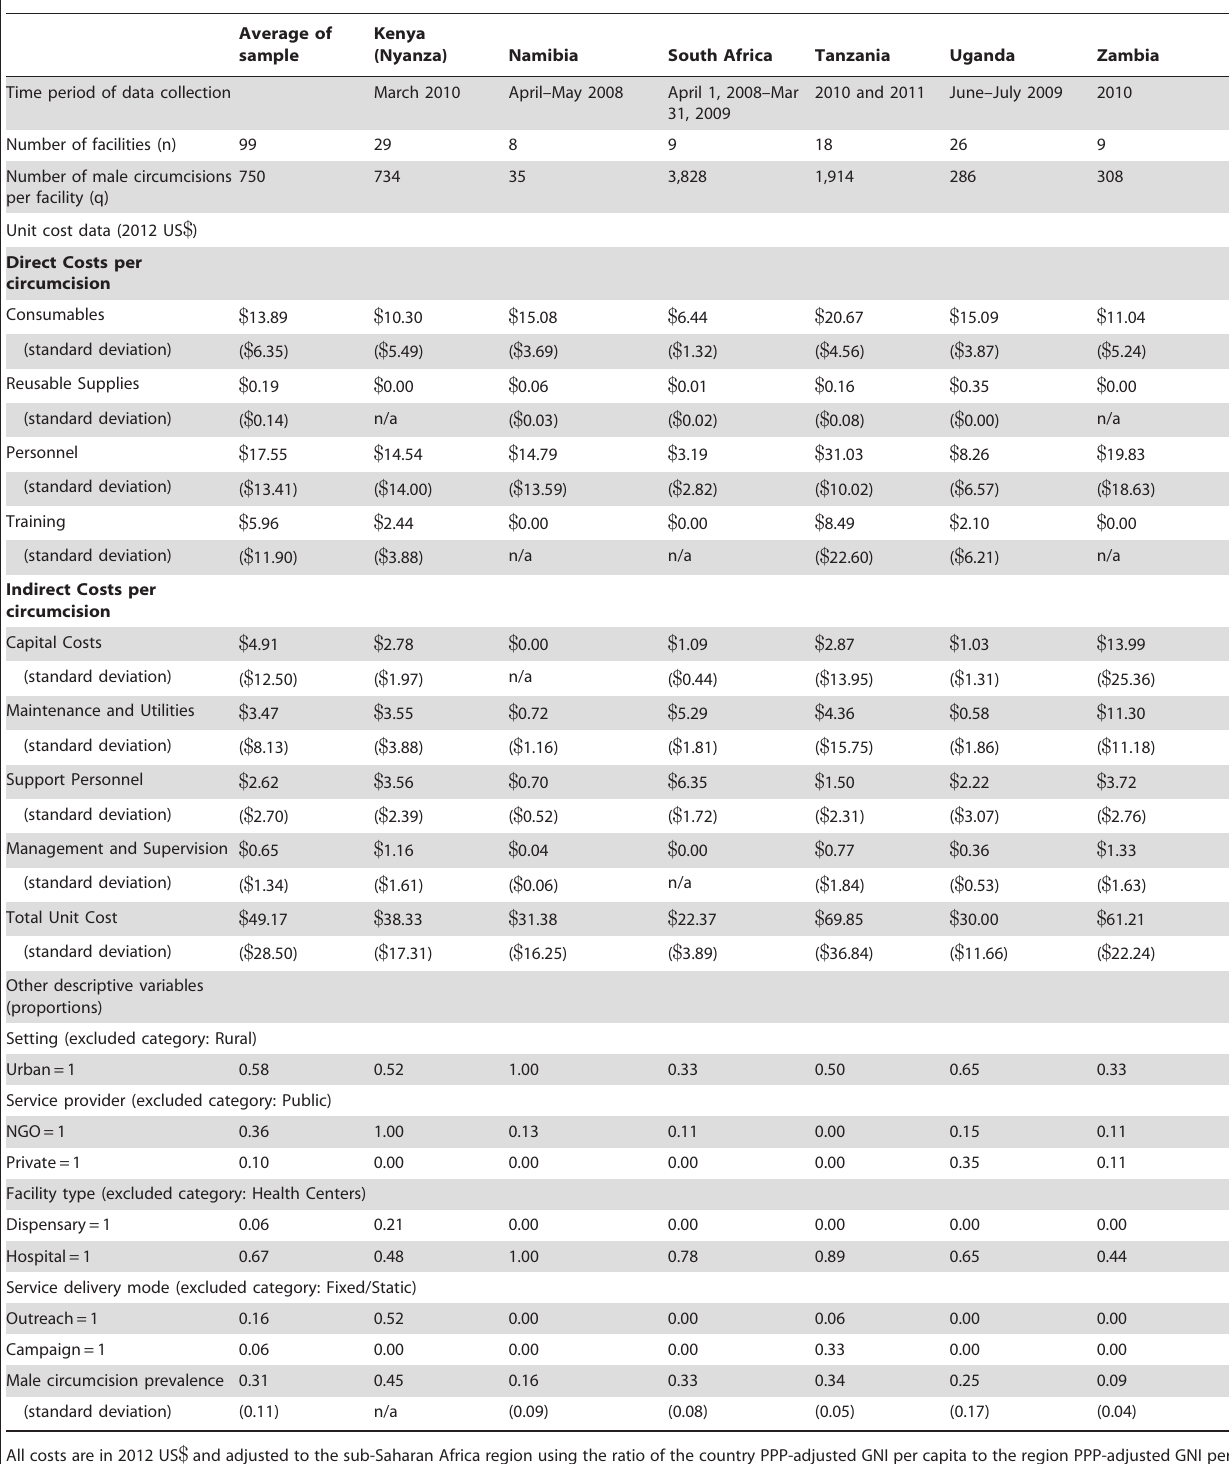
Table 1. Descriptive statistics for regression variables by country: Averages and (standard